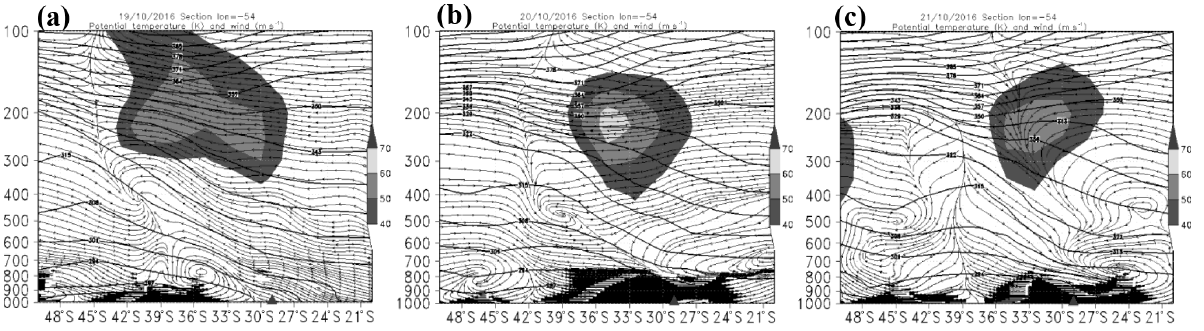
Figure 7. Vertical cut between 1000 and 100hPa showing the presence of jet streams at high